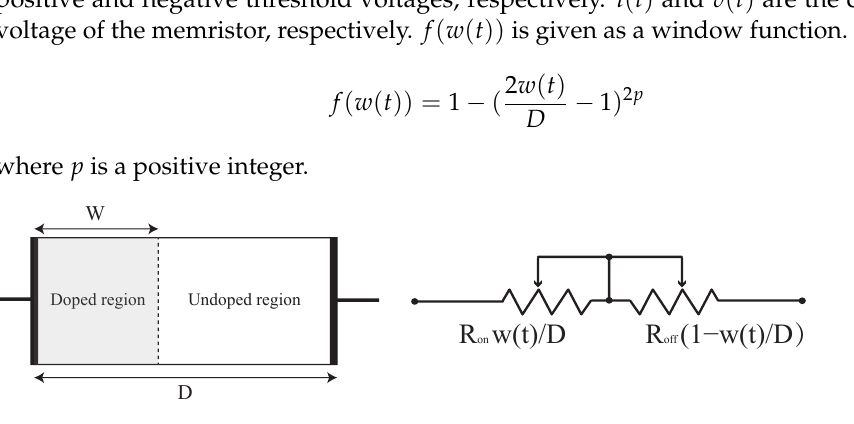
Figure 1. Basic model of the memristor.